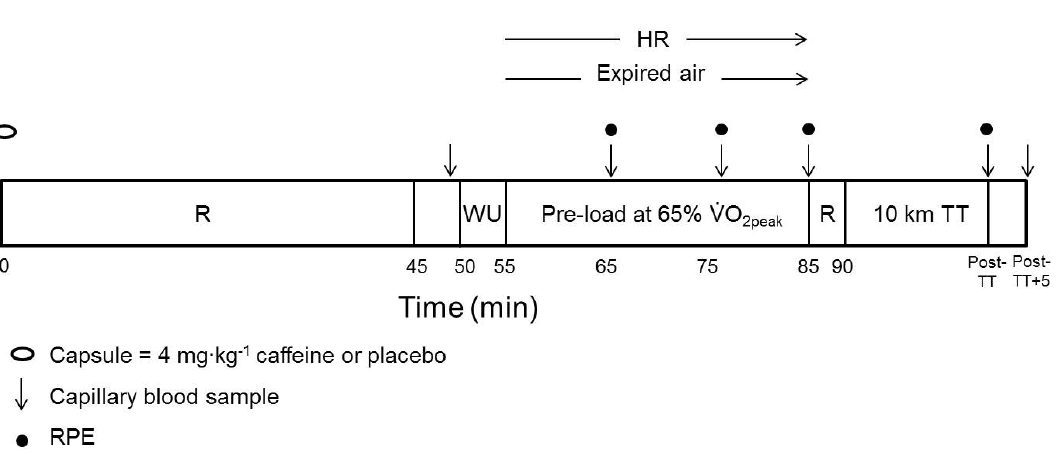
Figure 1. Schematic outline of the preloaded time trial (TT) experimental protocol. HR = heart rate; R = rest; WU = warm-up; and RPE = ratings of perceived exertion.